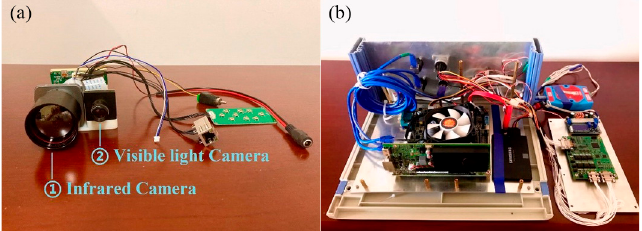
Figure 2. Details of ( a ) dual-spectrum camera (VS and IR camera) and ( b ) industrial computer.